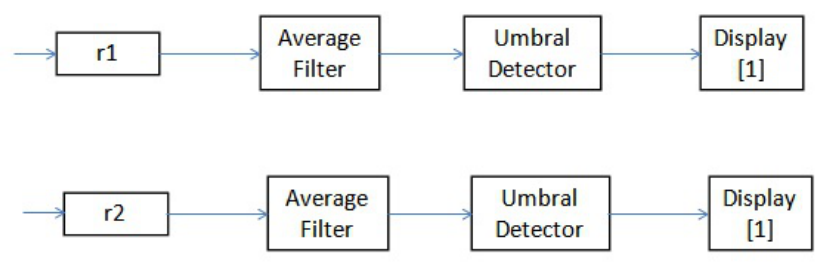
Figure 6. Developed response assessment scheme.